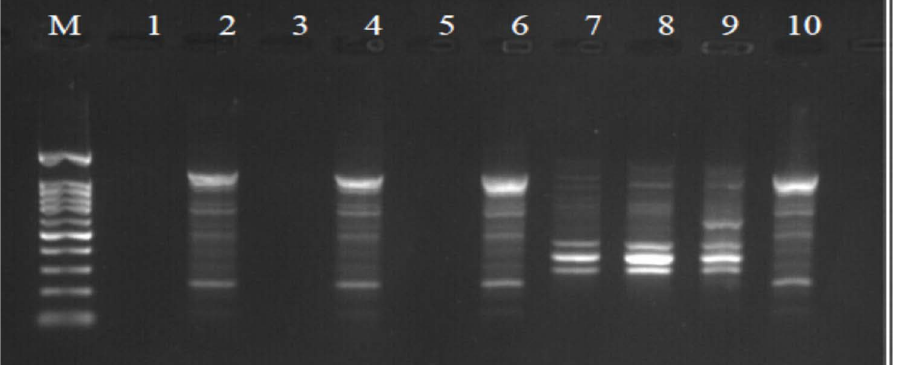
Fig. 4. Agarose gel electrophoresis of OPA-5 amplified product. The electrophoresis pattern of genomic DNA extracted from fenugreek ( Trigonella foenum-graecum ) leaf samples: 1, control; 2, Th-1; 3, Th-2; 4, AVG; 5, MeJA; 6, Th-1 + AVG; 7 Th-1 + MeJA; 8, Th-2 + AVG; 9, Th-2 + MeJA; 10, MeJA + AVG; M, DNA size marker.